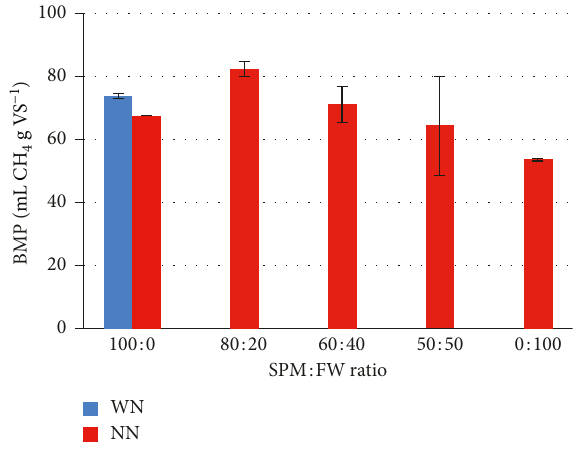
Figure 2: BMP for each SPM: FW